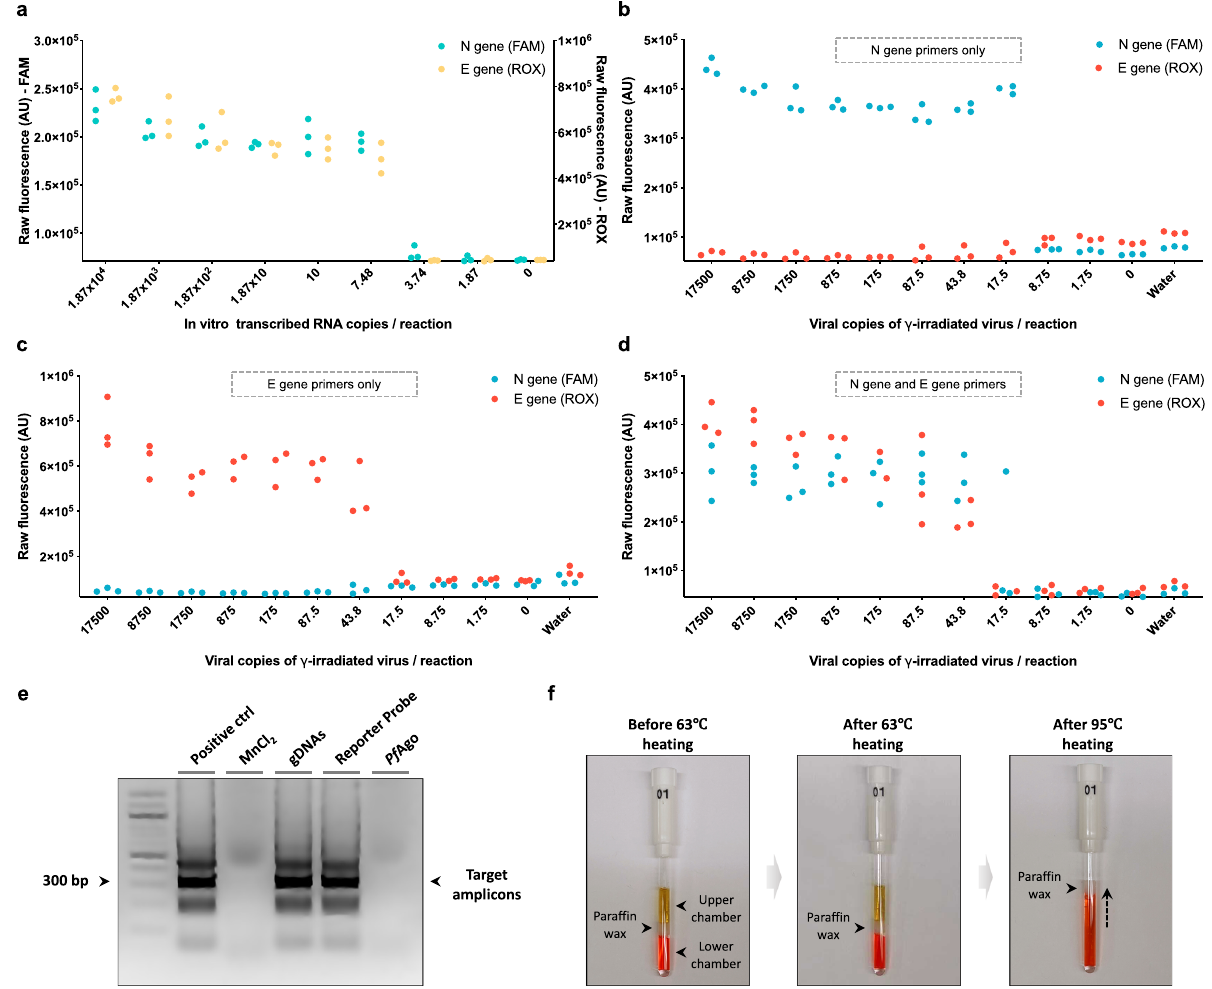
Fig. 2 Optimization and validation of the SPOT assay. a LoD using RNA samples. Reactions were performed in a thermocycler and fl uorescence values were measured on a qPCR machine ( n = 3) using SARS-CoV-2 N and E genes IVT RNAs; b LoD using virus-spiked saliva samples with only N gene corresponding primers. Reactions were performed in a thermocycler and fl uorescence values were measured using a qPCR machine ( n = 3); c LoD using virus-spiked saliva samples with only E gene corresponding primers. Reactions were performed in a thermocycler and fl uorescence values were measured using a qPCR machine ( n = 3); d Multiplexity of the assay. Both N gene and E gene corresponding primers were added. Reactions were performed in a thermocycler and fl uorescence values were measured using a qPCR machine ( n = 3); e Pf Ago detection components affect LAMP reaction. Lanes from left to right: LAMP positive control, 0.5 mM manganese ion, 1 mM gDNAs, 0.3 μ M fl uorophore-quencher labeled reporter probe, 5.5 μ M Pf Ago added (this experiment was repeated three times with similar results); f Strategy for compartmenting two reactions: the upper chamber (yellow liquid represents RT- LAMP reaction) and the lower chamber (red liquid represents mixture of Pf Ago and manganese ion) are separated by paraf fi n wax (melting point above 70 °C). Source data are provided as a Source Data fi